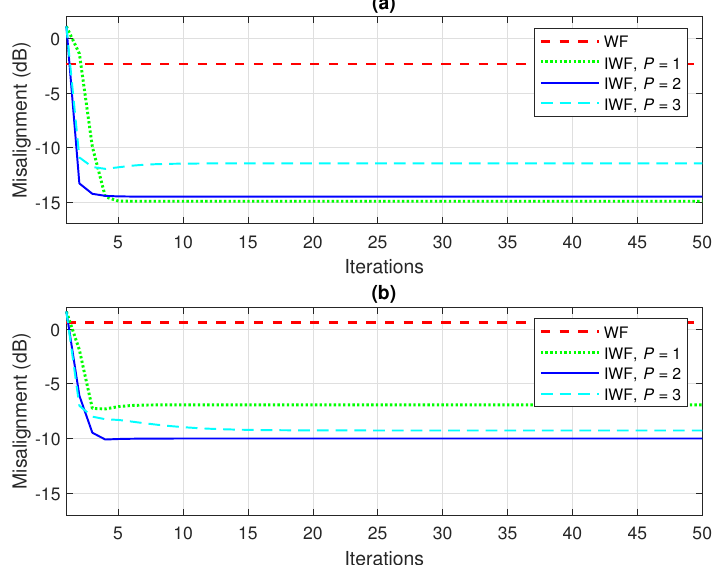
Figure 5. Performance of the conventional Wiener filter (WF) and the iterative Wiener filter (IWF) for the identification of ( a ) the network echo path from Figure 1a and ( b ) the network echo path from Figure 1b. The input signal is an AR(1) process, N = 1000 (available data samples), and SNR = 10